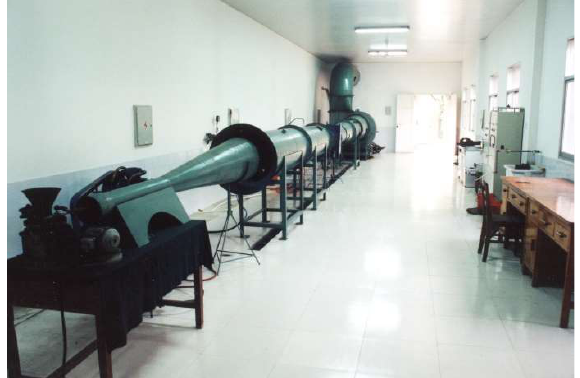
Figure 8. Experimental device for dust collection by swirling curtain.